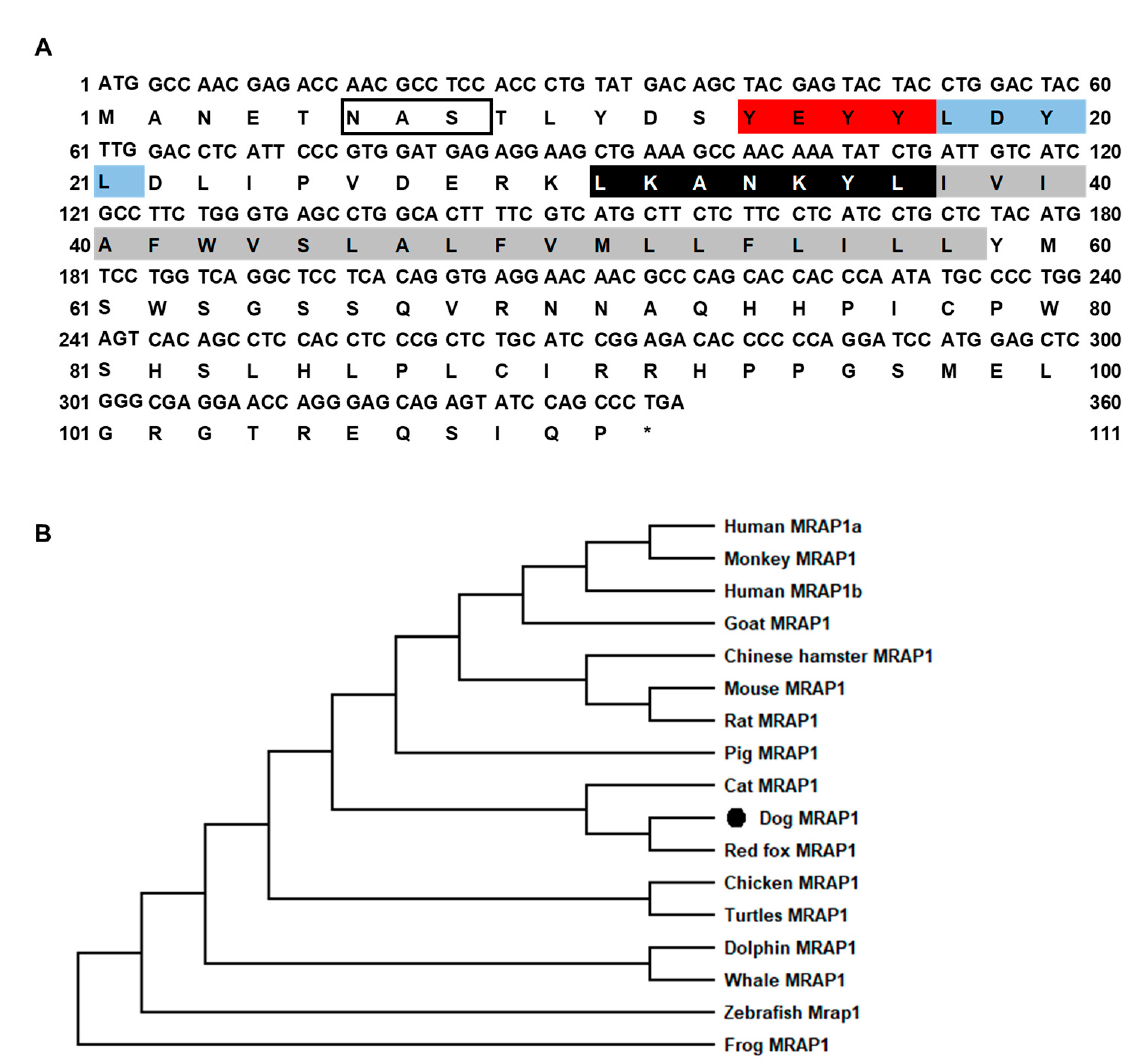
Figure 2. Nucleotide and deduced amino acid sequences ( A ) and phylogenetic tree ( B ) of cMRAP1. Positions of nucleotide and amino acid sequences are indicated on both sides. N -linked glycosylation sites are present in open boxes. Red box denotes YEYY motif. Light blue box indicates LDYL motif. Black box is LKANKYL motif. Shaded box shows putative TMD. Asterisk (*) shows stop codon. The tree was constructed by the neighbor-joining (NJ) method. Numbers at nodes indicate the bootstrap value, as percentages, obtained for 1000 replicates. Black dot denotes canine MRAP1. MRAP1s: Canis lupus familiaris (dog, XP_005638887.1),